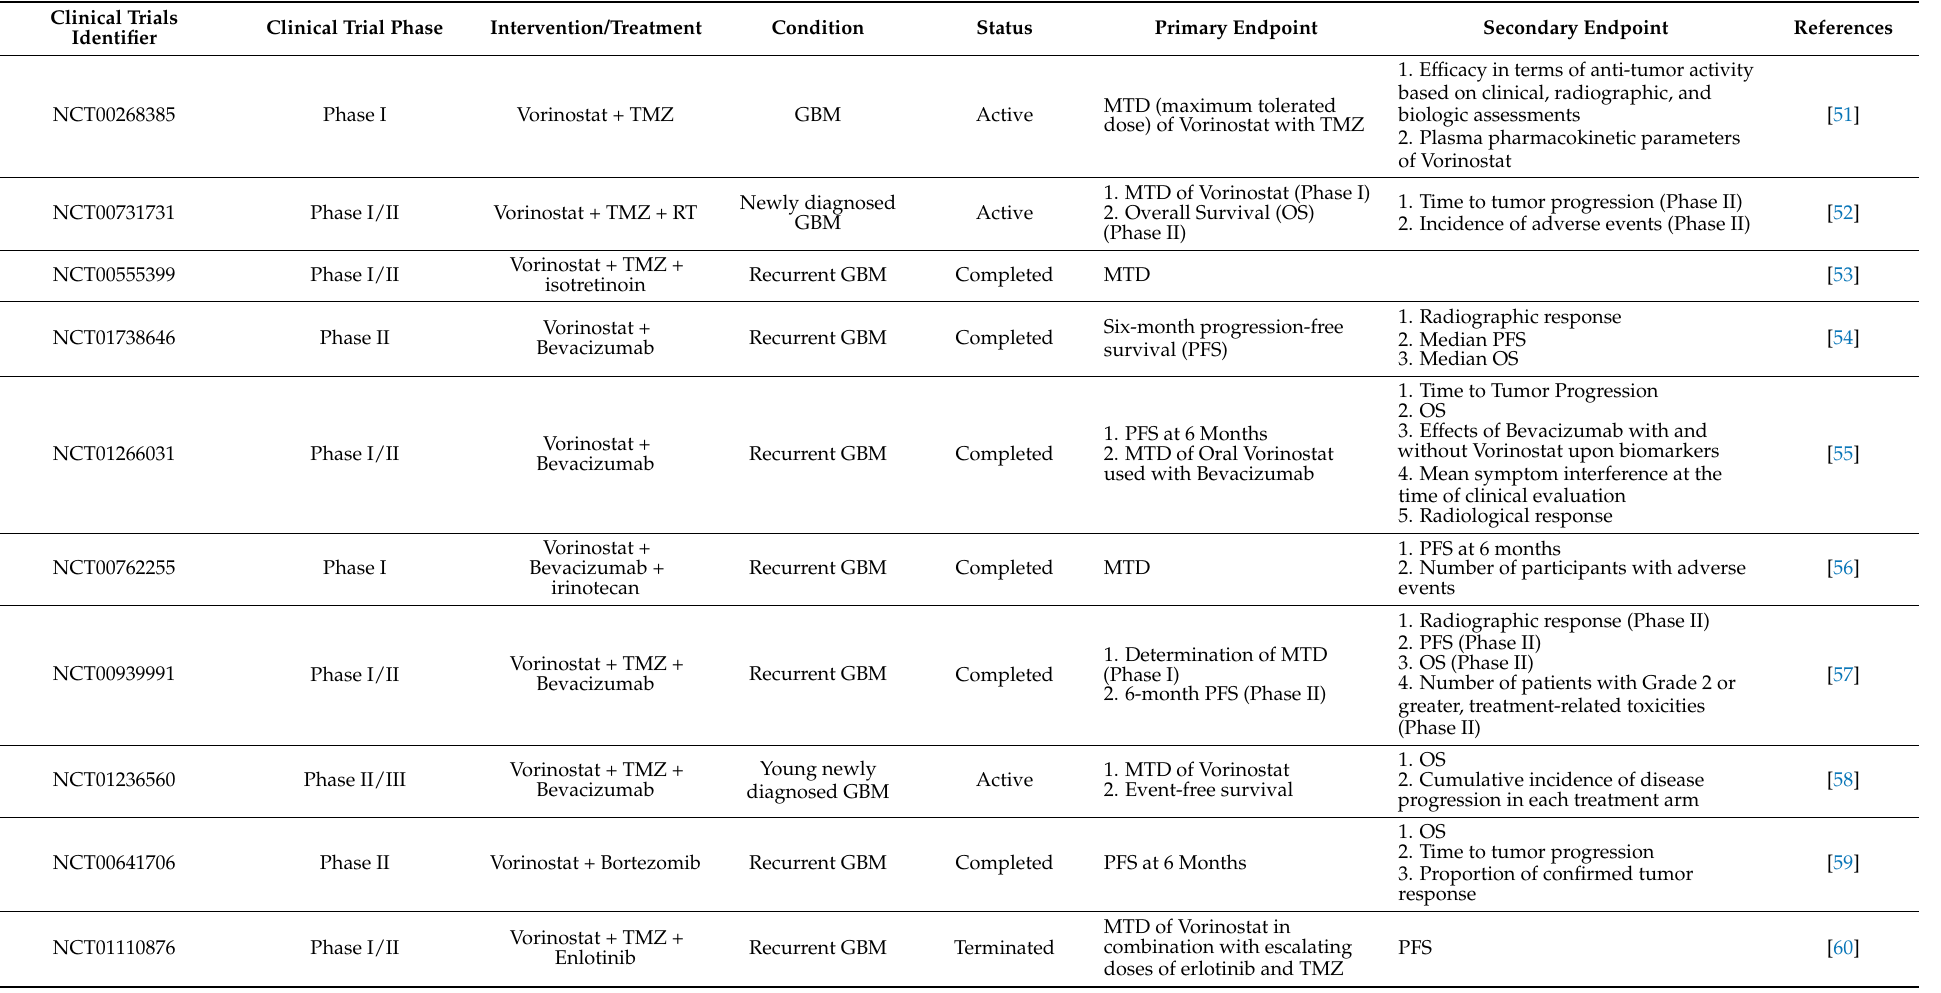
Table 1. Development of combination therapy using epigenetic drugs for the treatment of